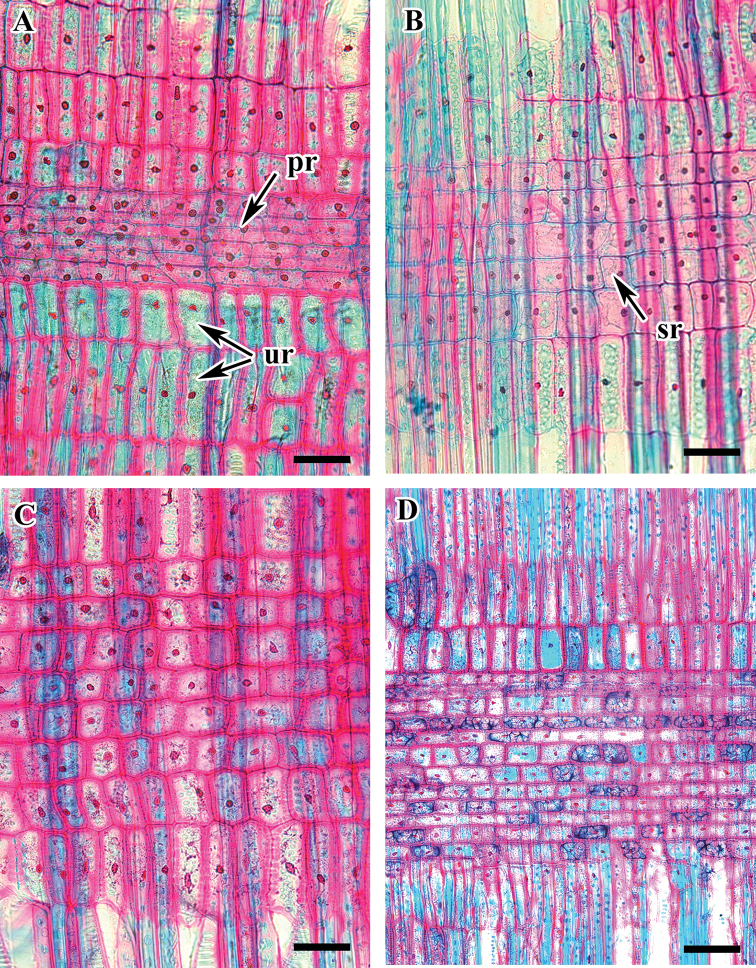
Radial longitudinal section (RLS) of Viburnum wood showing ray and parenchyma. AV.
erosumBV.
carlesiiCV.
burejaeticumDV.
furcatum. Abbreviations: pr, procambium ray cells; sr, square ray cells; ur, upright ray cells. v, vessel. Scale bars: 20 µm.